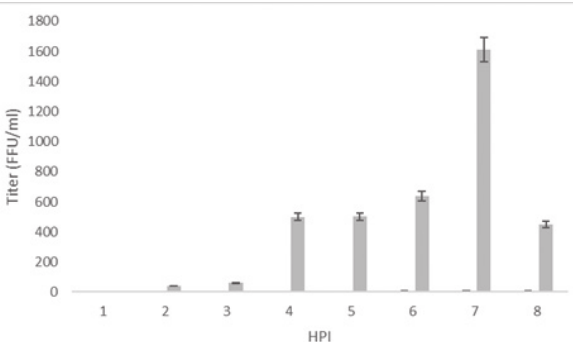
Figure 1. DENV-2 Titer in Supernatant Brain of Mice, (HPI = days post infection).